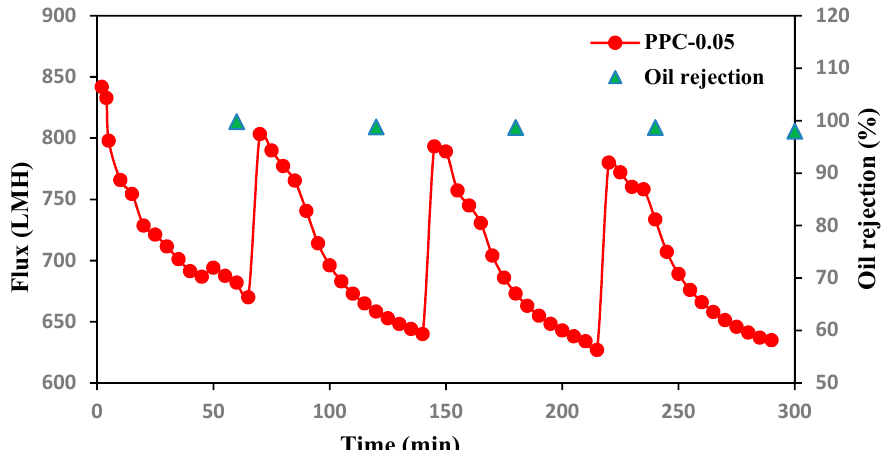
Figure 13. Oil Flux and rejection recycles for PPC-0.05 membrane versus time in Four filtration cycles after caustic soda cleaning.